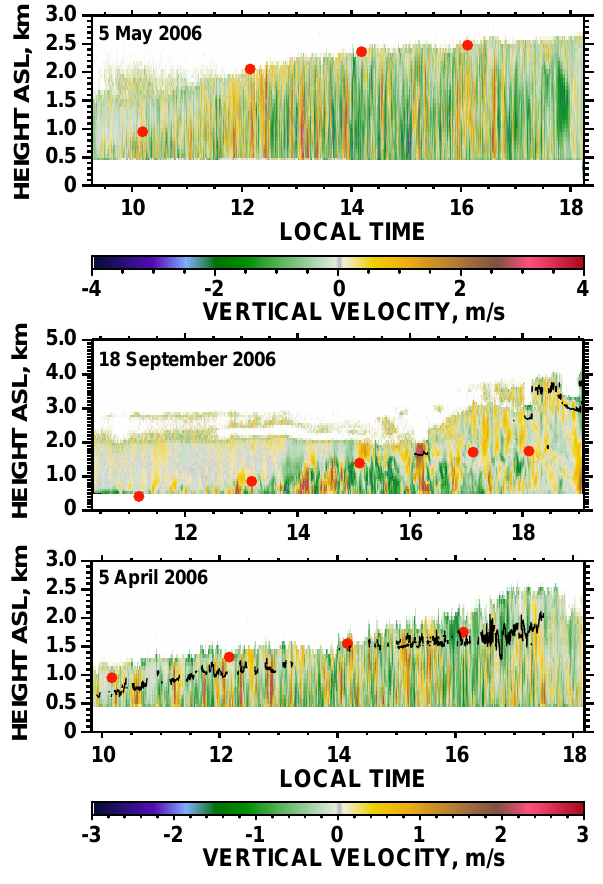
Fig. 1. Evolution of the ABL in terms of vertical velocity observed with Doppler lidar (resolution: 5s, 75m) at Leipzig on 5 May 2006 (top), 18 September 2006 (center), and 5 April 2006 (bottom). Yellow and red (positive velocities) indicate upward movements, whereas green and blue (negative velocities) represent downward movements. Red circles show the general trend in the increase of the ABL top height as observed with an automated aerosol li- dar. Cloud base heights of convective clouds are indicated by black lines. Lidar signals from the near range (region of detector satu- ration) are not trustworthy and thus not shown. 12:00 Local Time (LT, daylight saving time) is 11:00 Central European Time (CET) and 10:00